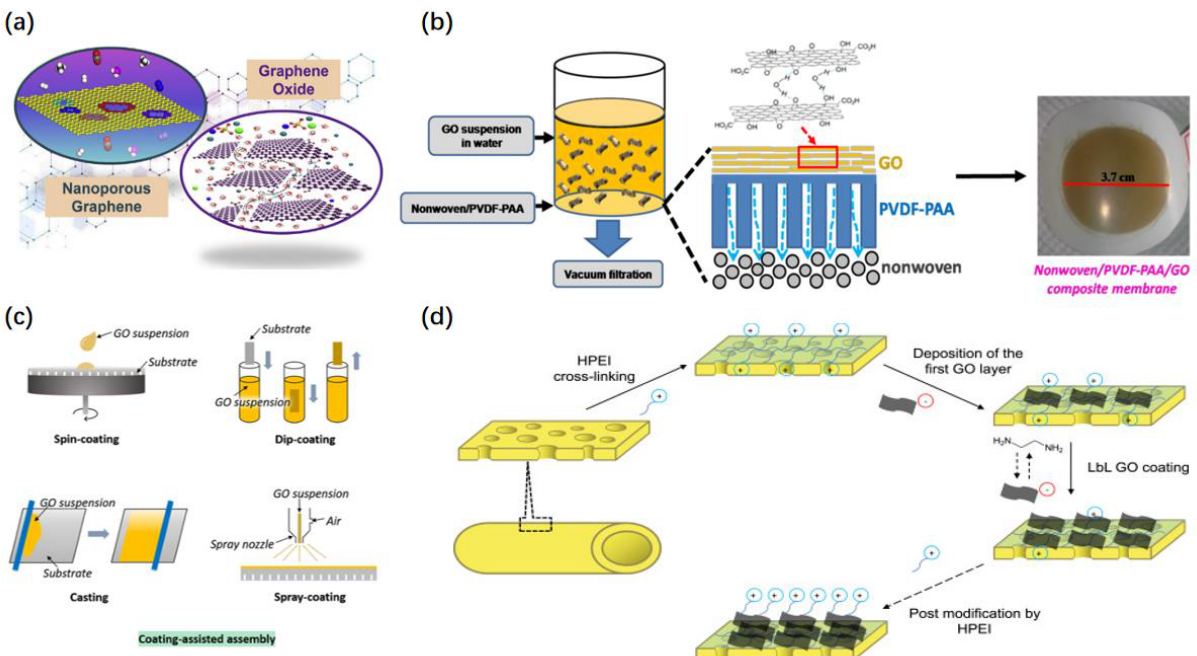
Figure 2. ( a ) Schematic diagram of two graphene-based films, including NPG film (left) and GO film (right). (Printed image with permission from Ref. [45], copyright 2021, American Chemistry Society). ( b ) Vacuum filtration method. (Printed image with permission from Ref. [49], copyright 2018, Elsevier Ltd.). ( c ) Coating-assisted assembly. (Printed image with permission from Ref. [52], copyright 2016, Nature Publication). ( d ) Schematic diagram of the procedure for constructing LbL GO framework films. (Printed image with permission from Ref. [50], copyright 2016, Elsevier Ltd.).